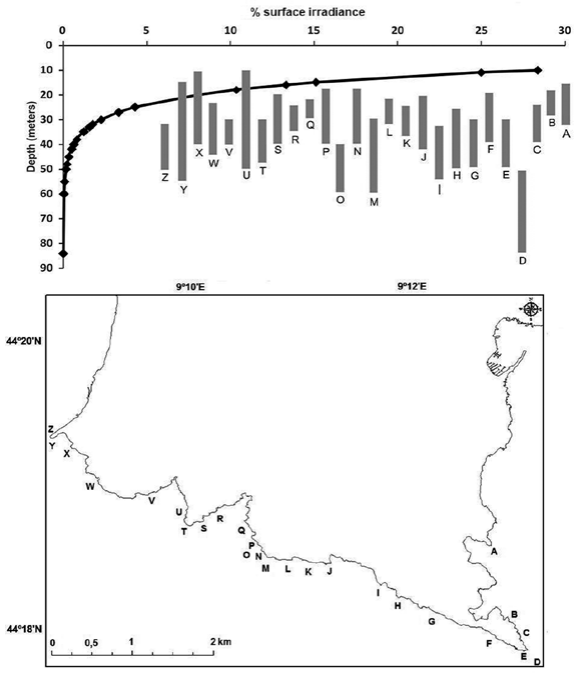
Fig. 4. – Incident light values on coralligenous assemblages of Por- tofino. A, Punta Cervara; B, Punta Coppo; C, Punta dell’Aurora; D, Dorsale Portofino; E, Punta Faro; F, Chiesa San Giorgio; G, Casa del Sindaco; H, Punta Vessinaro; I, Punta dell’Altare; J, Punta Fregante; K, Testa del Leone; L, Scoglio del Raviolo; M, Secca Gonzatti; N, Punta Carega; O, Scogliera del Dragone; P, Tetto del Dragone; Q, Cristo degli Abissi; R, San Fruttuoso; S, Punta Volpe; T, Punta Torretta; U, Cala dell’Oro Est; V, Cala dell’Oro Ovest; W, Punta Bussago; X, Punta Targuetta; Y, Secca dell’Isuela; Z, Punta Chiappa.